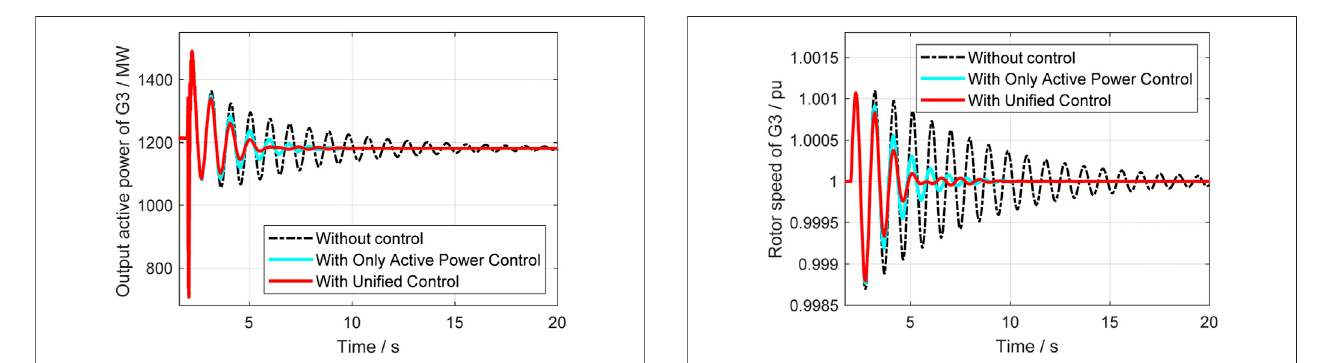
FIGURE 24 | Rotor speeds of G3 with different